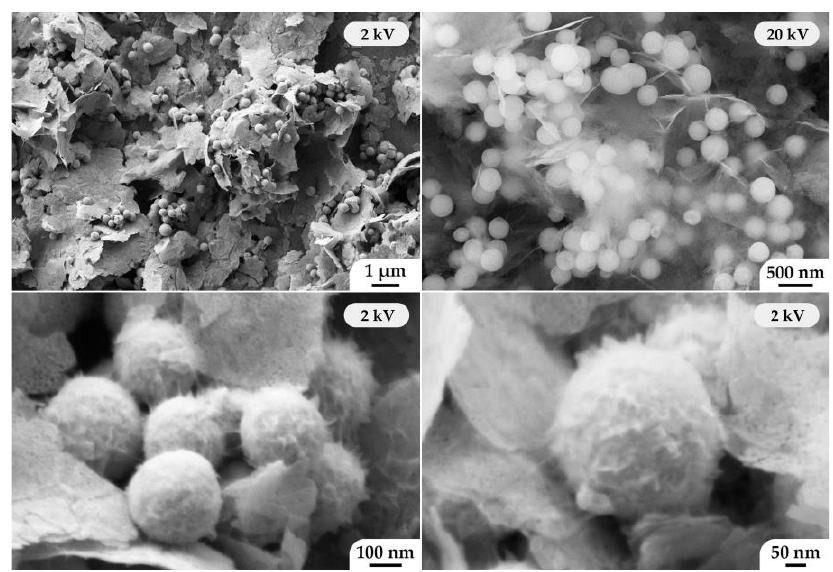
Figure 5. Microstructure of the obtained ((CeO 2 ) 0.8 (Sm 2 O 3 ) 0.2 )@NiO powder with the core-shell structure according to the SEM data.